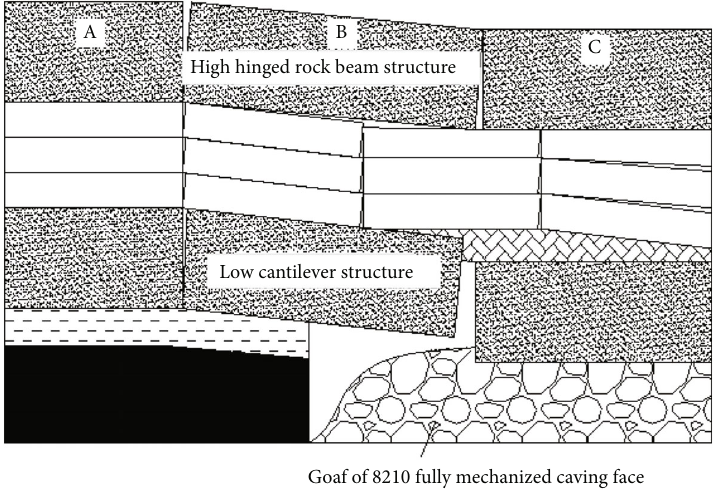
Figure 4: Overburden structure characteristics.